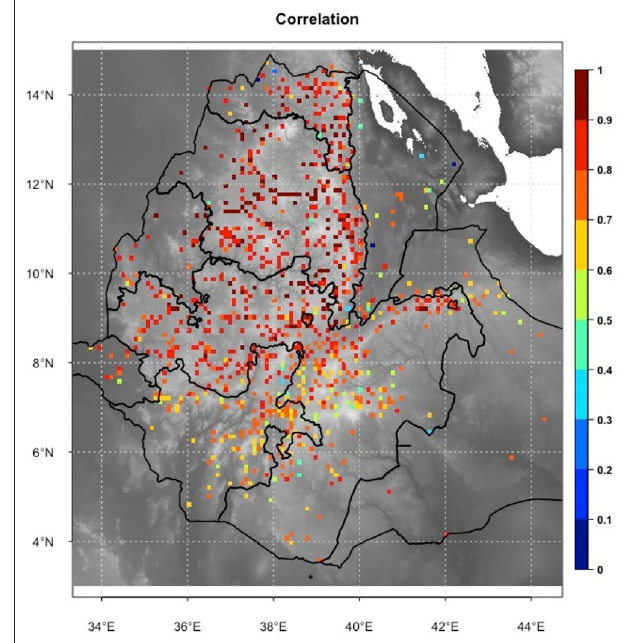
FIGURE 14 | Correlation Coefficients from cross-validation of monthly RR plotted with DEM as